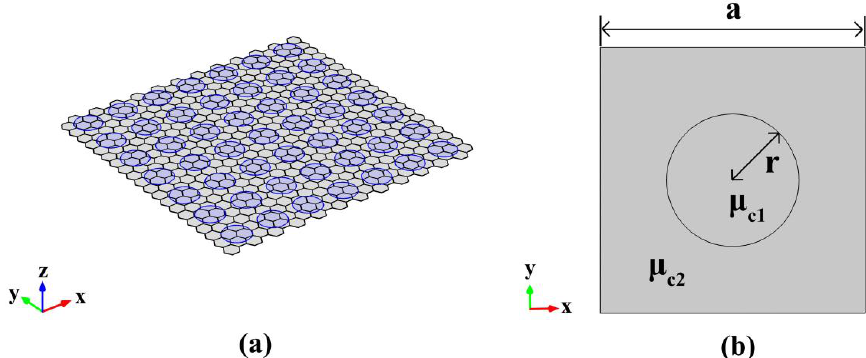
Figure 2. ( a ) Three-dimensional (3D) view of the proposed two-dimensional (2D) graphene-based plasmonic PhC. ( b ) The computational window of schematic diagram of graphene-based 2D plasmonic PhC, where lattice constant a = 20 nm, and r = 5 nm.